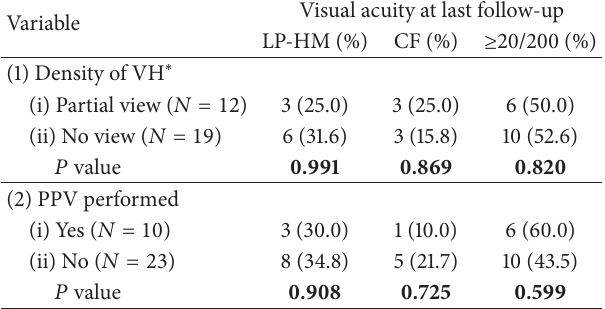
Table 8: Factors predicting visual acuity at last follow-up for eyes with vitreous hemorrhage caused by accidental trauma. Vision was available in 165 out of 187